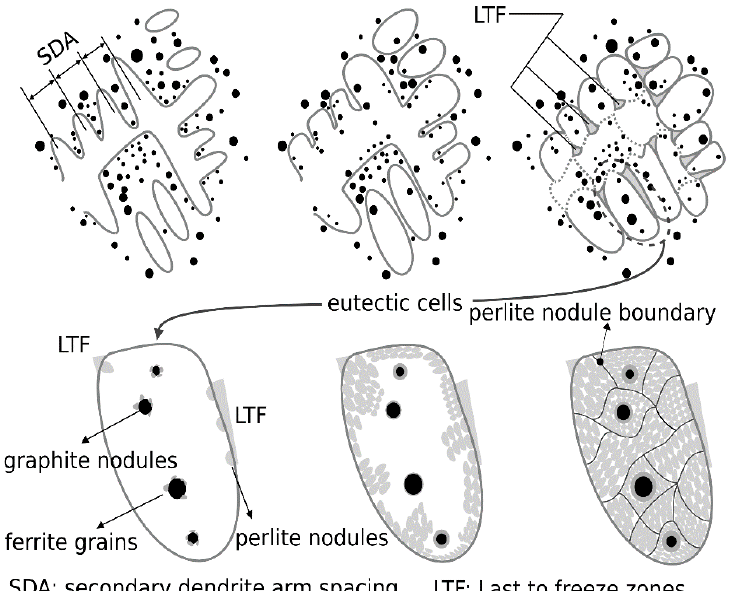
Figure 2. Schematic representation of the nucleation and growth steps in pearlite transformation in spheroidal graphite cast irons (SGI) as assumed in the present model.